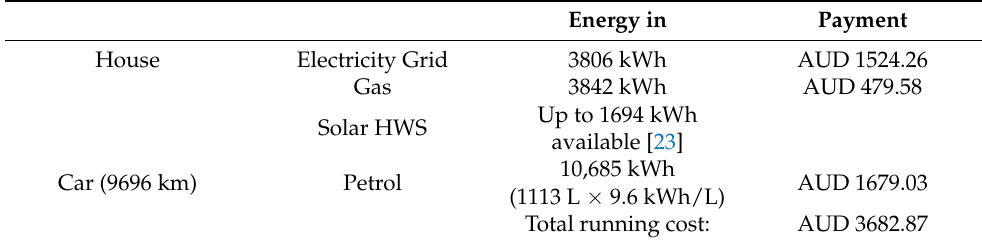
Table 1. Energy use prior to installing solar panels (May 2013–April